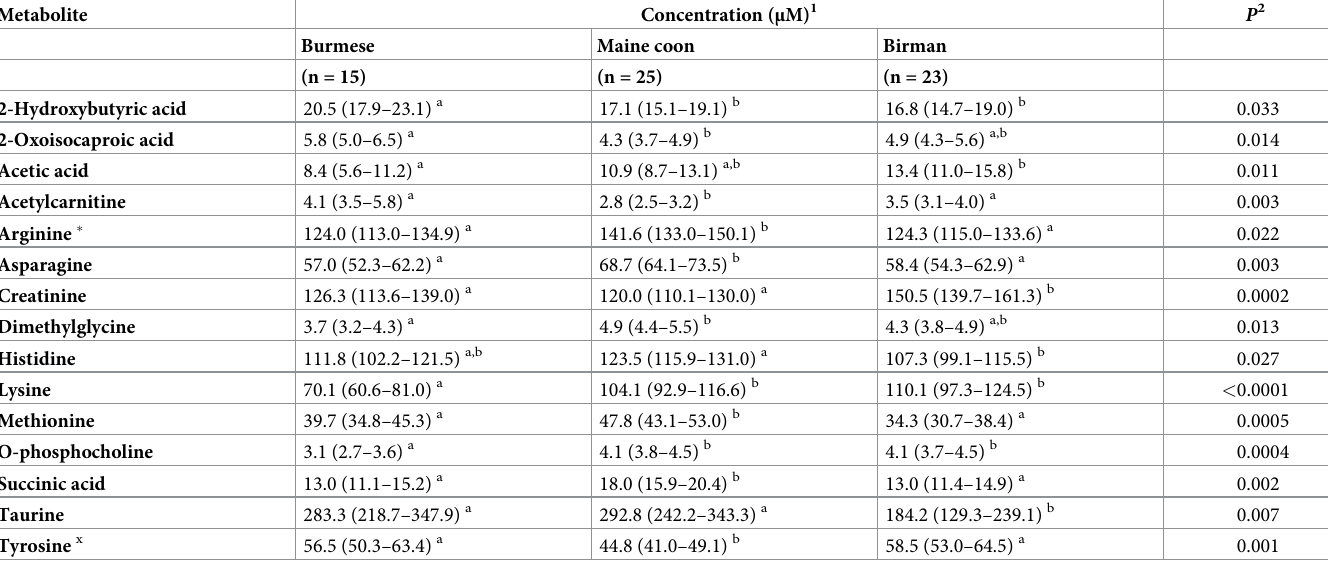
Table 4. Metabolites remaining discriminant for breeds after adjusting for body weight and body condition